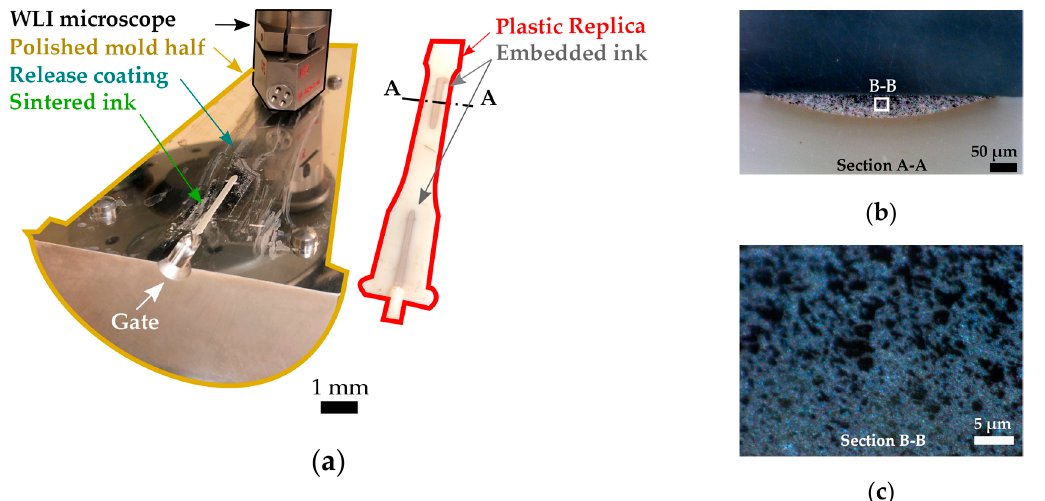
Figure 3. ( a ) Characterization of the mold before injection and the plastic replica after transfer. ( b ) Cross-section of the plastic part with the embedded traces, and ( c ) high magnification of the ink embedded in the printed traces.